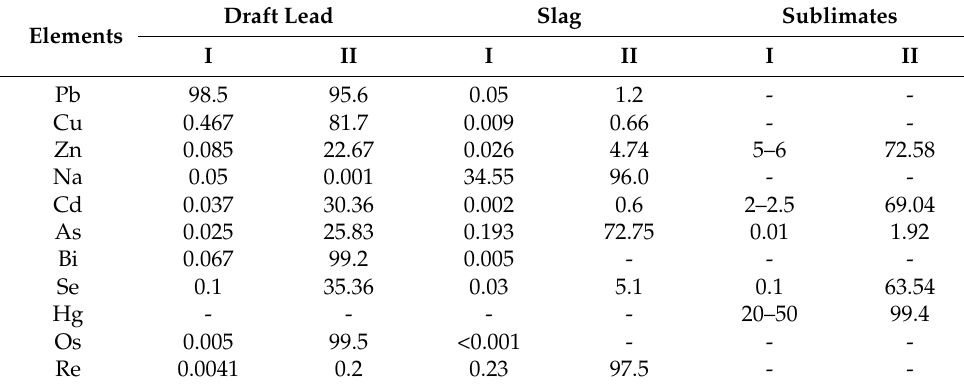
Table 2. Distribution of elements in the products of reduction